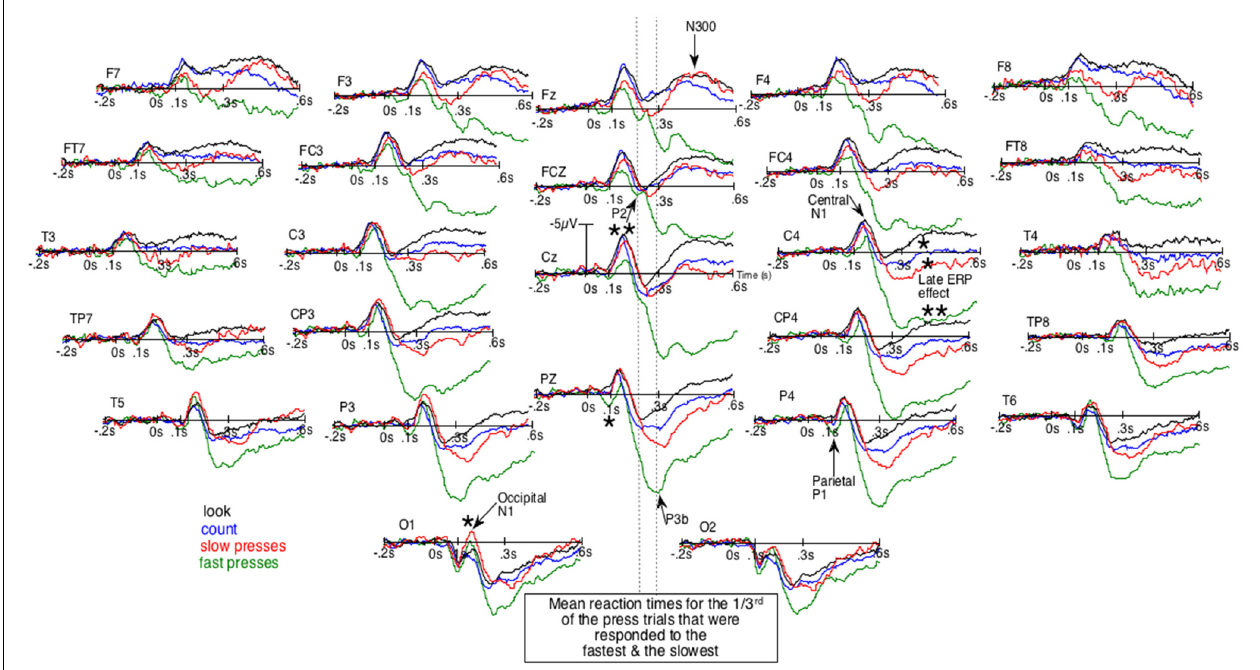
FIGURE 1 | Unsmoothed grand average ( n = 20) of the event-related brain potentials (ERPs) elicited by the occurrence of the space bar of a keyboard out of the dark. Negative polarity is plotted upward. Green lines are for the fastest reaction-times (RTs) trials of the block-task where the subjects had to press the space bar as fast as possible. Red lines are for the slowest RTs trials of that task. Blue lines are for the block-task where participants had to count mentally the number of appearances of that space bar. Black lines are for the block-task where they just had to look at the space bar. The order of these three tasks was counterbalanced across subjects. ∗ p < 0.05; ∗∗ p <